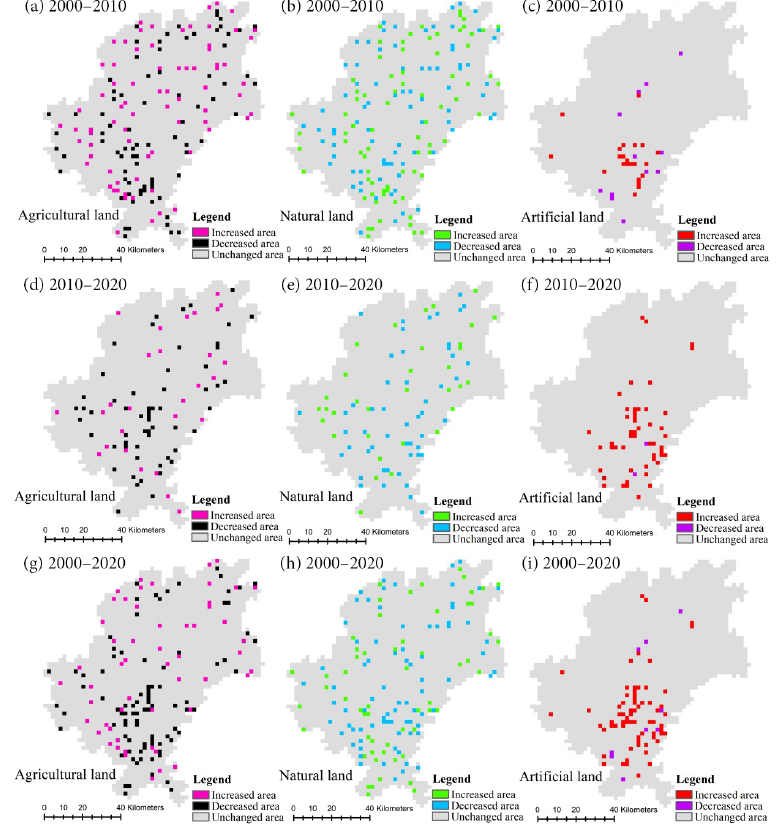
Figure 11. Spatial pattern of land use change in Guiyang city. The agricultural land includes paddy field and dry land. The natural land includes forestland, shrubland, grassland and water body. The artificial land consists of urban land, rural settlement, industrial and mining land, road land and railway